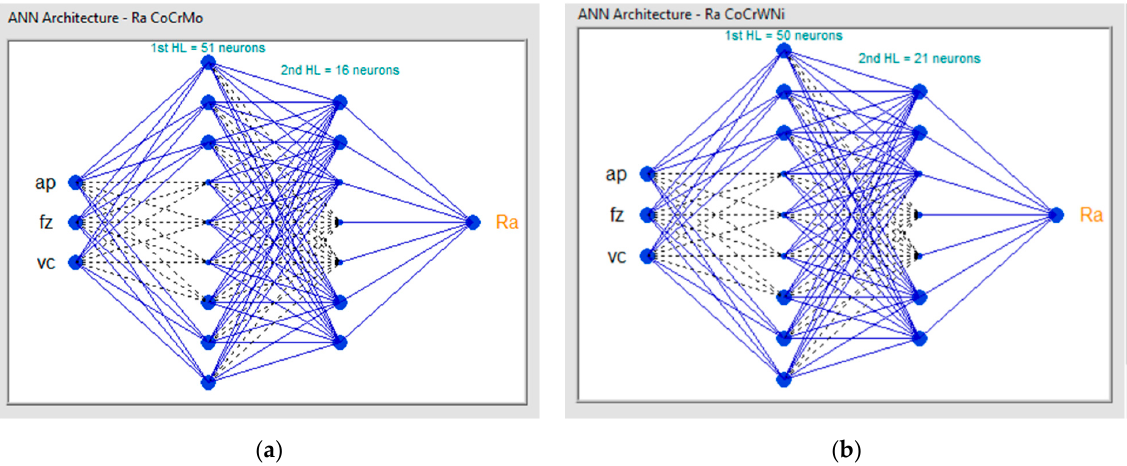
Figure 11. ANN architectures: ( a ) ANN 3:51:16:1 for Co-28Cr-6Mo; ( b ) ANN 3:50:21:1 for Co–20Cr–15W–10Ni.